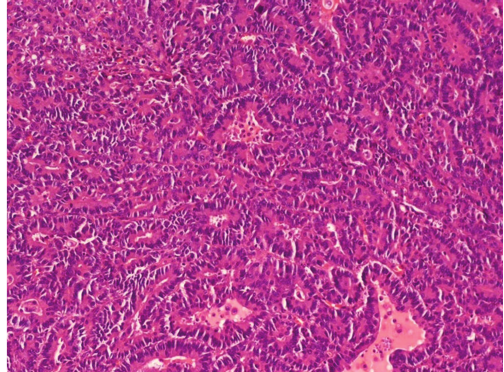
Figure 2: Primary colon adenocarcinoma.